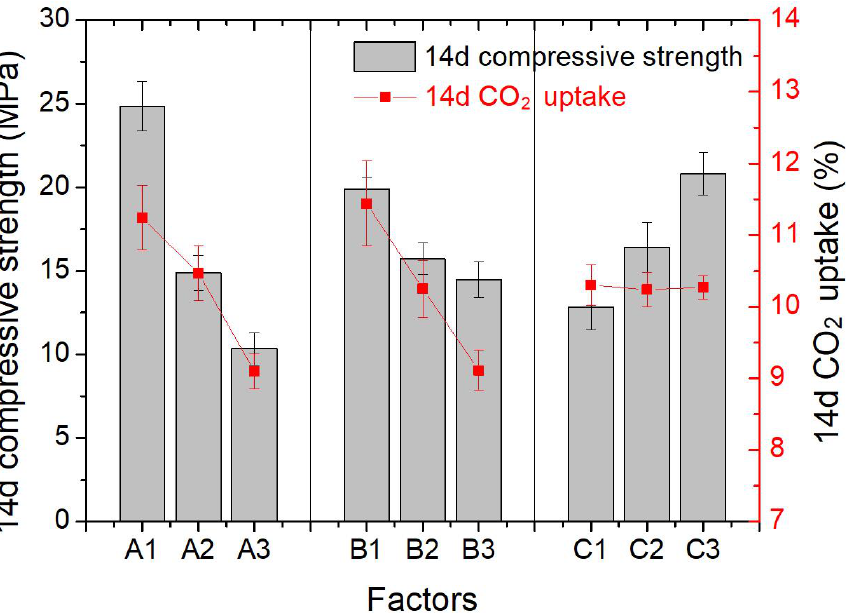
Figure 5. The effect curve of three factors on 14 d compressive strength and 14 d CO 2 uptake capacity.